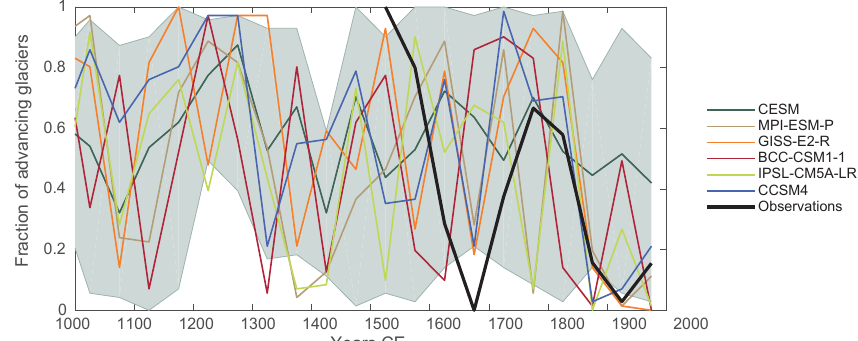
Figure 5. Proportion of glacier advances binned for 50-year